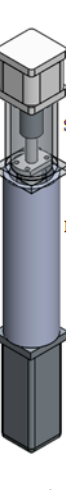
Figure 12. Diagram of single measurement channel.